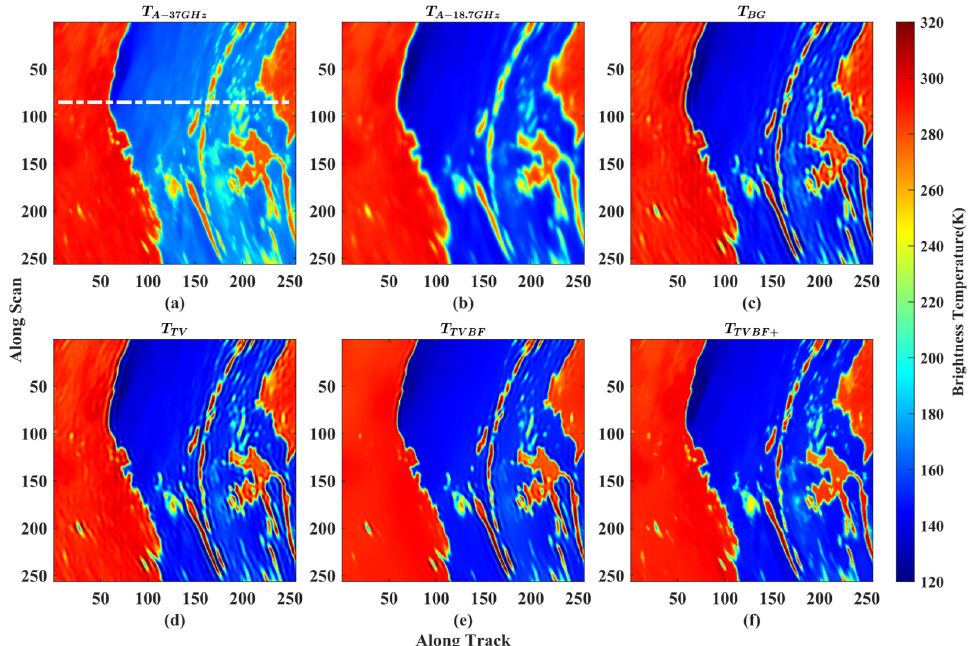
Figure 14. The actual MWRI scenario and resolution enhancement results. ( a ) Actual 37 GHz scene temperature; ( b ) actual 18.7 GHz antenna temperature; ( c ) the Backus–Gilbert enhancement results; ( d ) the TV enhancement results; ( e ) the TVBF enhancement results; ( f ) the TVBF + enhancement results.